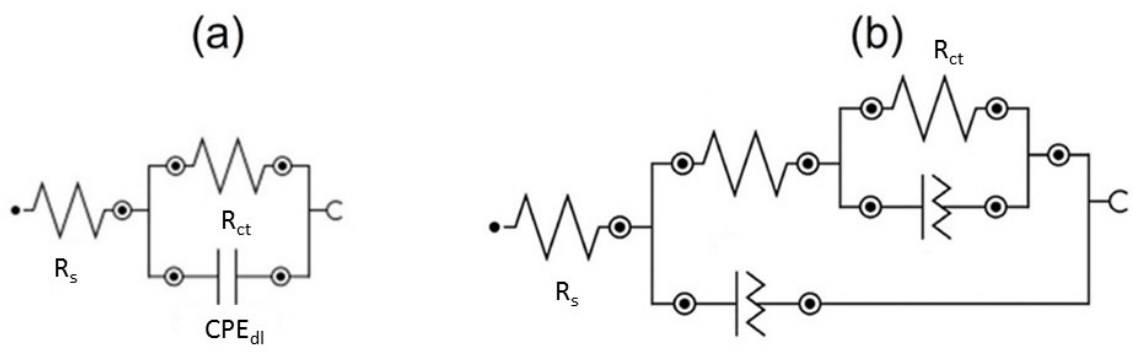
Coatings 2022 , 12 , x FOR PEER REVIEW 11 of 14 Figure 7. Schemes of the equivalent circuits used for modelling the EIS data in Figure 5. Scheme ( a ) was used for Cr-coated and ( b ) for copper substrate.